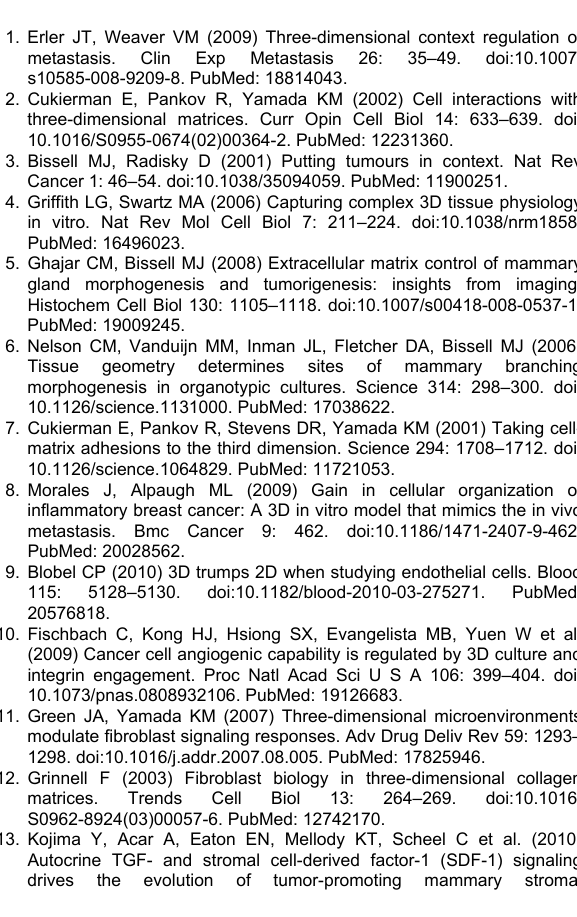
(TIFF) Figure S7. The effect of β1 integrin function blocking antibody. Bar graph shows data from HGF ELISA performed with conditioned media collected from 2D and 3D cultures of HMF and also with the β1 integrin function blocking antibody (25 μg/ml). ‡ represents a p value of less than 0.05. (TIFF) Table S1. Summary of the differences of macro (i.e., transwells) vs. micro co-culture